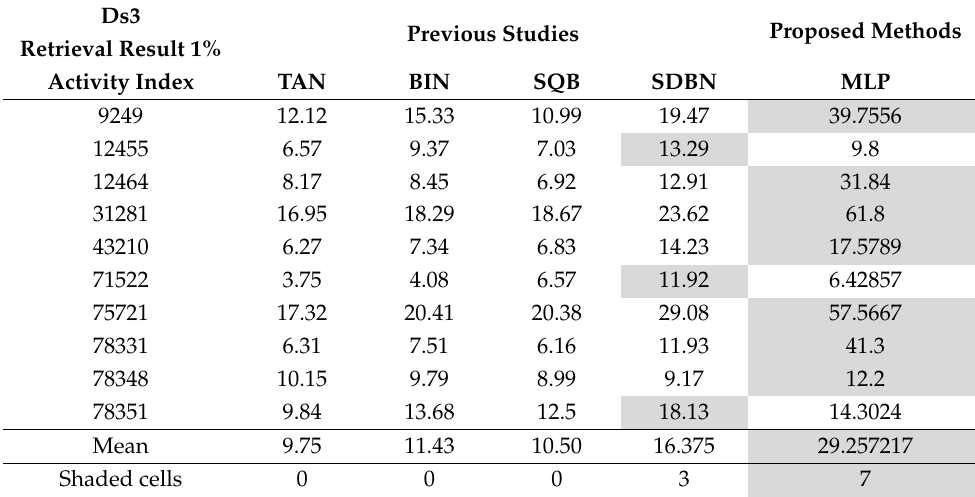
Table 10. Top 1% retrieval results for MDDR-DS3 dataset for descriptor (ECFC 4).